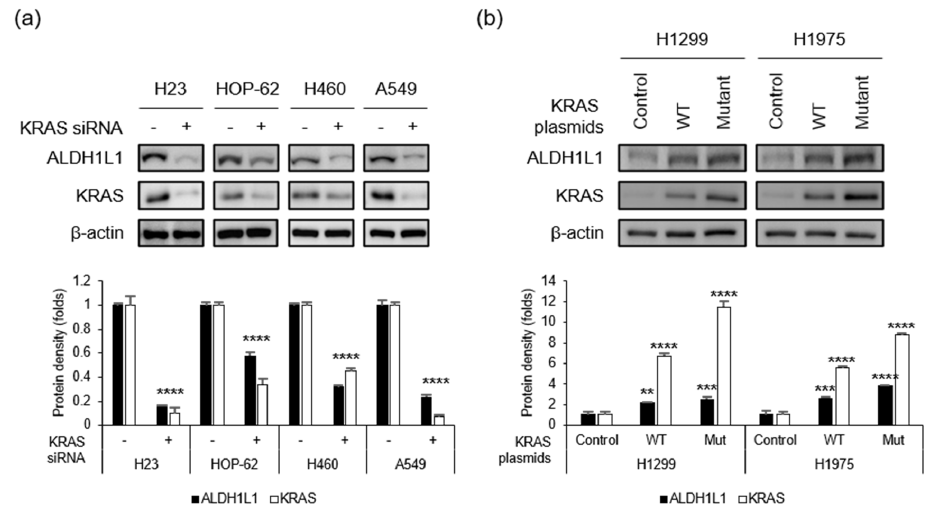
Figure 1. KRAS regulates ALDH1L1 expression. ( a ) KRAS-mutant NSCLC cells were treated with control or KRAS siRNA, and then subjected to immunoblotting with the indicated